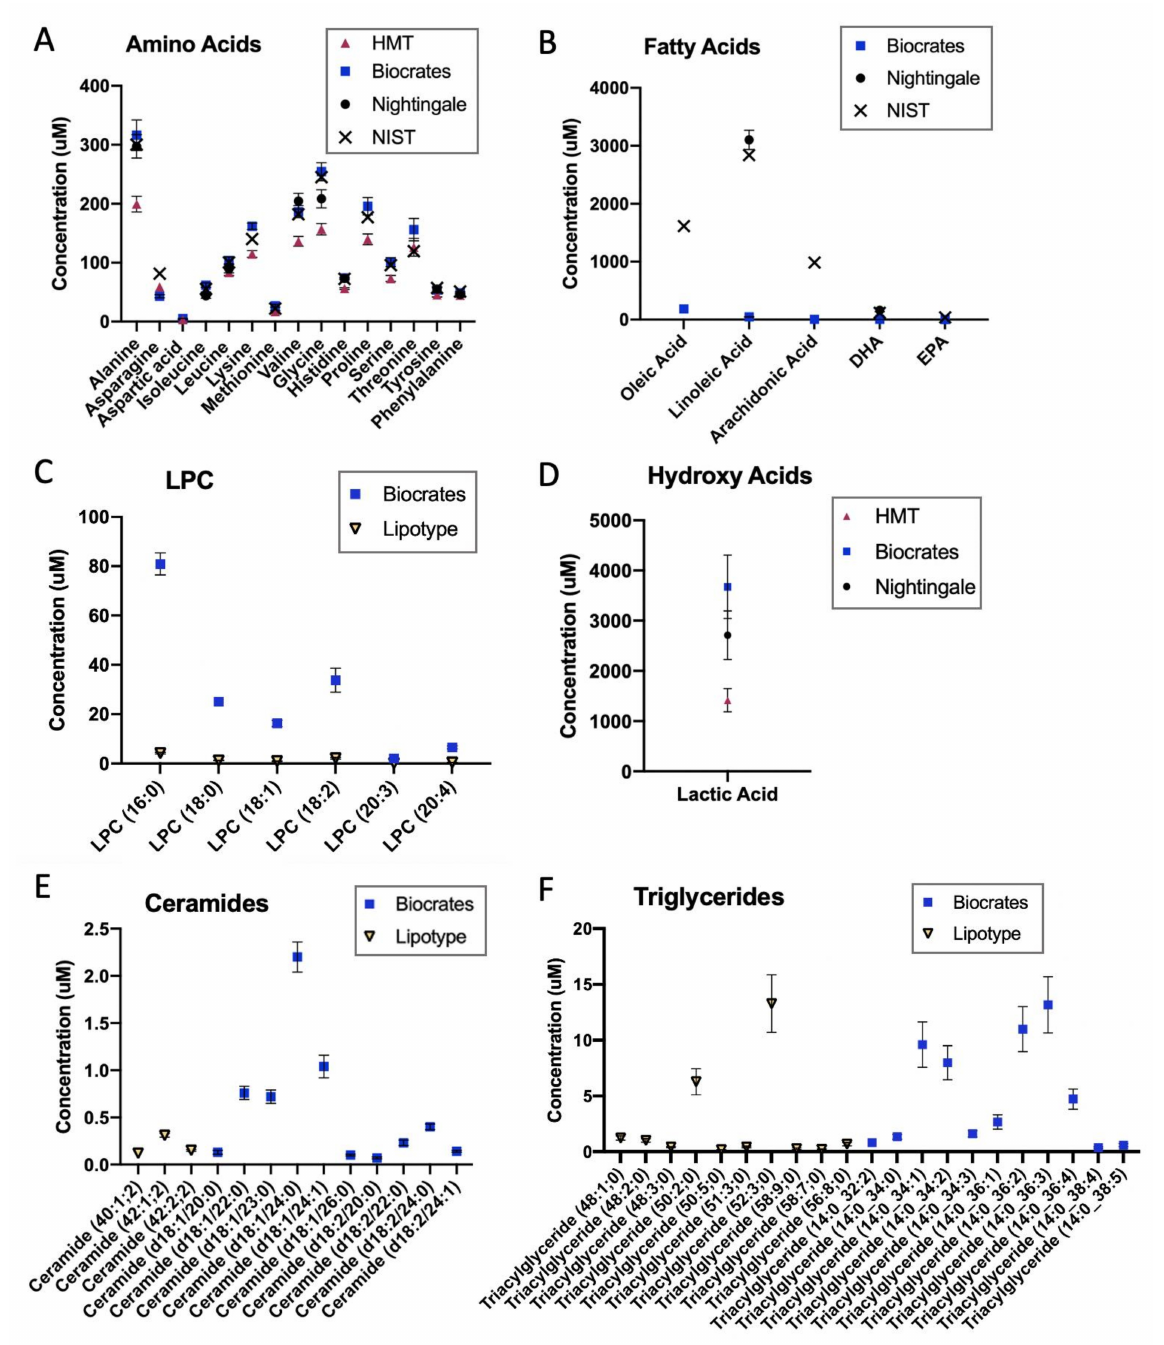
Figure 4. Platform-specific average metabolite levels in control samples for vendors reporting absolute units; each point represents mean ± SEM for 11 control samples in total: 9 control samples from 6 individuals (with 3 technical replicates), and 2 NIST pooled reference plasma samples. Each panel depicts the range of covered metabolites, across all assays, for an exemplar metabolite class: ( A ) amino acids, ( B ) fatty acids, ( C ) lysophosphatidylcholines (LPC), ( D ) hydrooxy acids, ( E ) ceramides, and ( F ) triglycerides. Depicted data are from the second sample shipment. NIST = concentrations reported